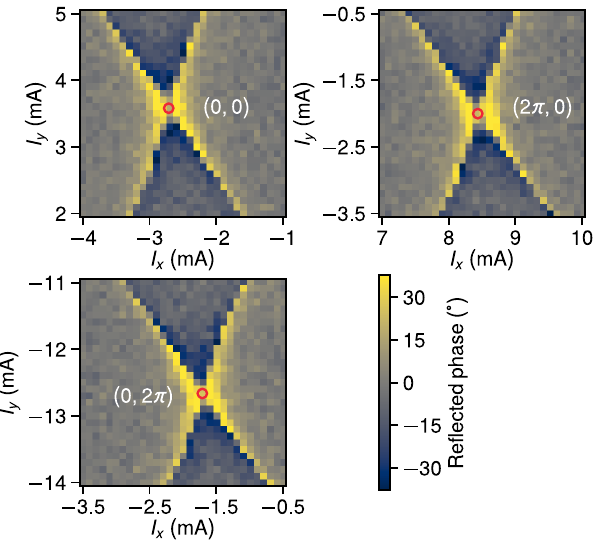
FIG. 7. Typical external flux calibration data. Phase of the reflected probe signal (color) on the readout port, at the fixed probe frequency of 5.580 GHz, as a function of both flux bias currents I and I . The three panels correspond to enlarged x y portions of Fig. 4(a), about the inversion-symmetric points ð φ ext ; θ ext Þ ¼ ð 0 ; 0 Þ , ð 2 π ; 0 Þ , and ð 0 ; 2 π Þ . Red circles indicate symmetry points extracted using image inversion convolution and are used to fully determine the mapping from ð I ; θ onto ð φ ext ext Þ